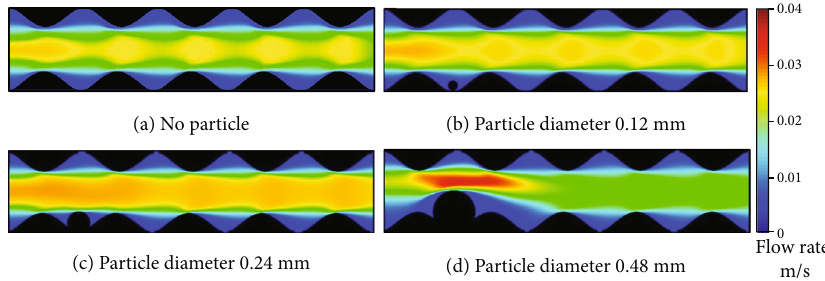
Figure 7: Velocity contours for a circular particle in a corrugated wall